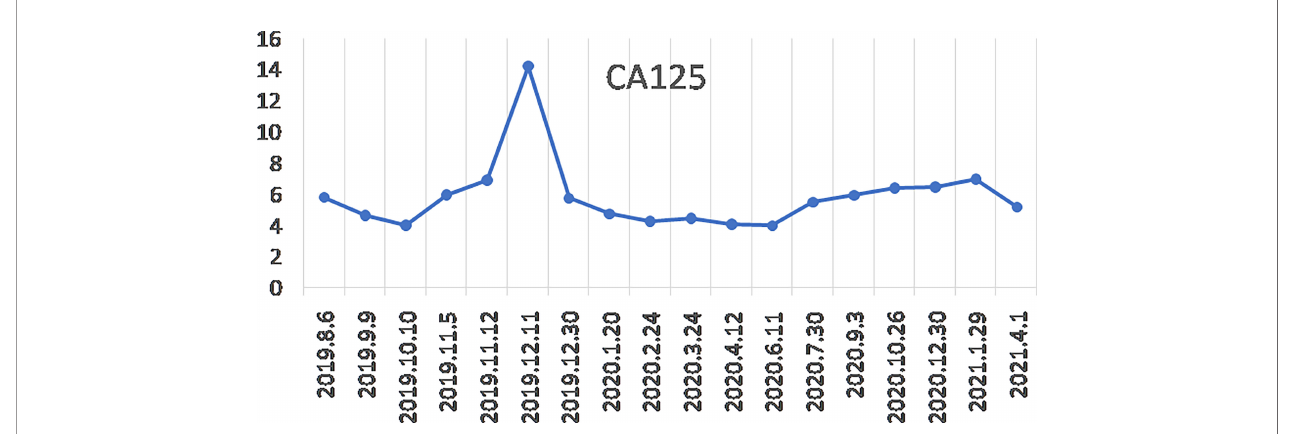
FIGURE 3 | Changes in serum CA125 levels since the start of niraparib treatment.